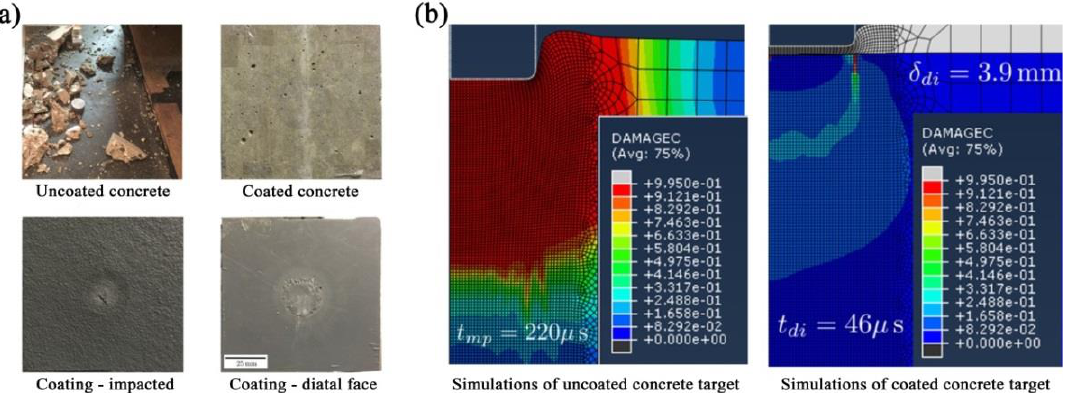
Figure 11. ( a ) Photographs and ( b ) simulations of the test specimens for a projectile impact velocity of 100 m·s −1 . Reproduced with permission from ref. [109].